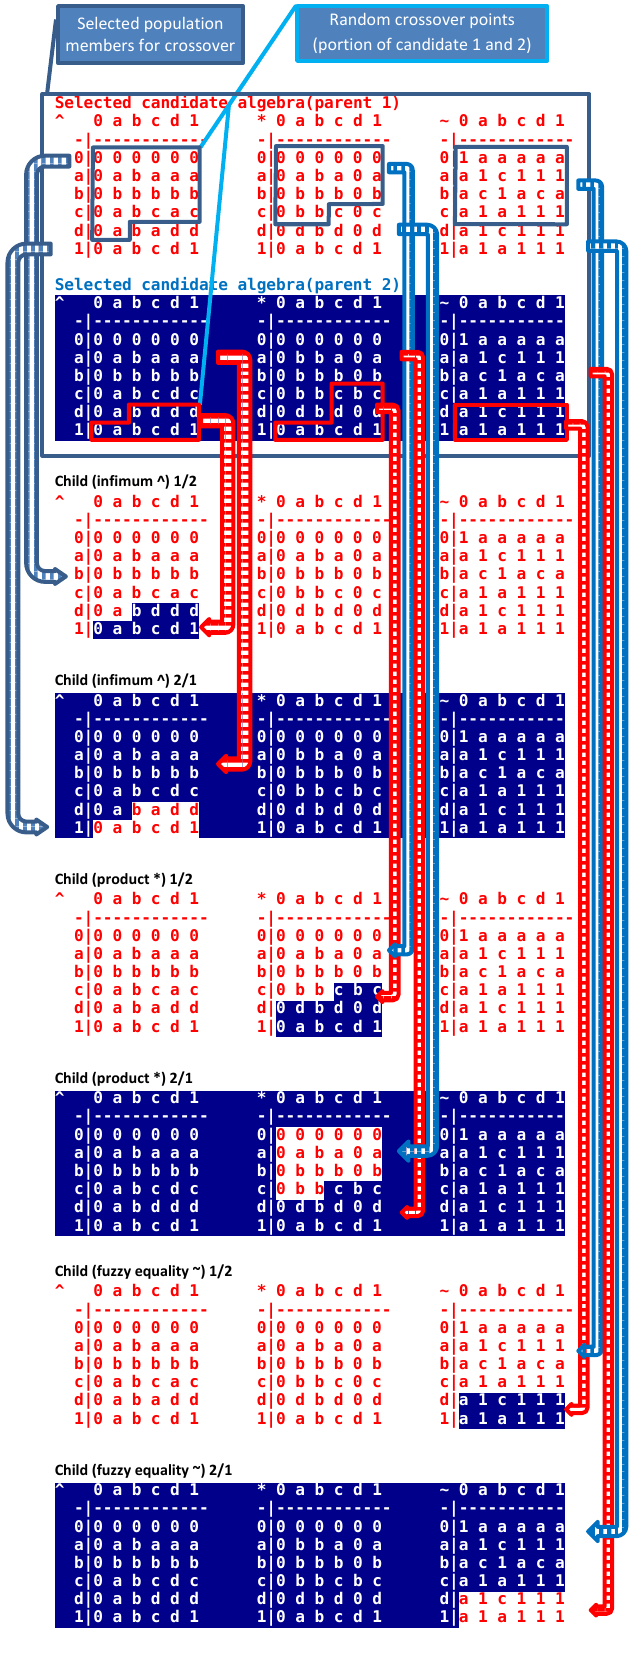
Figure 6. Specific exponential crossover by algebra